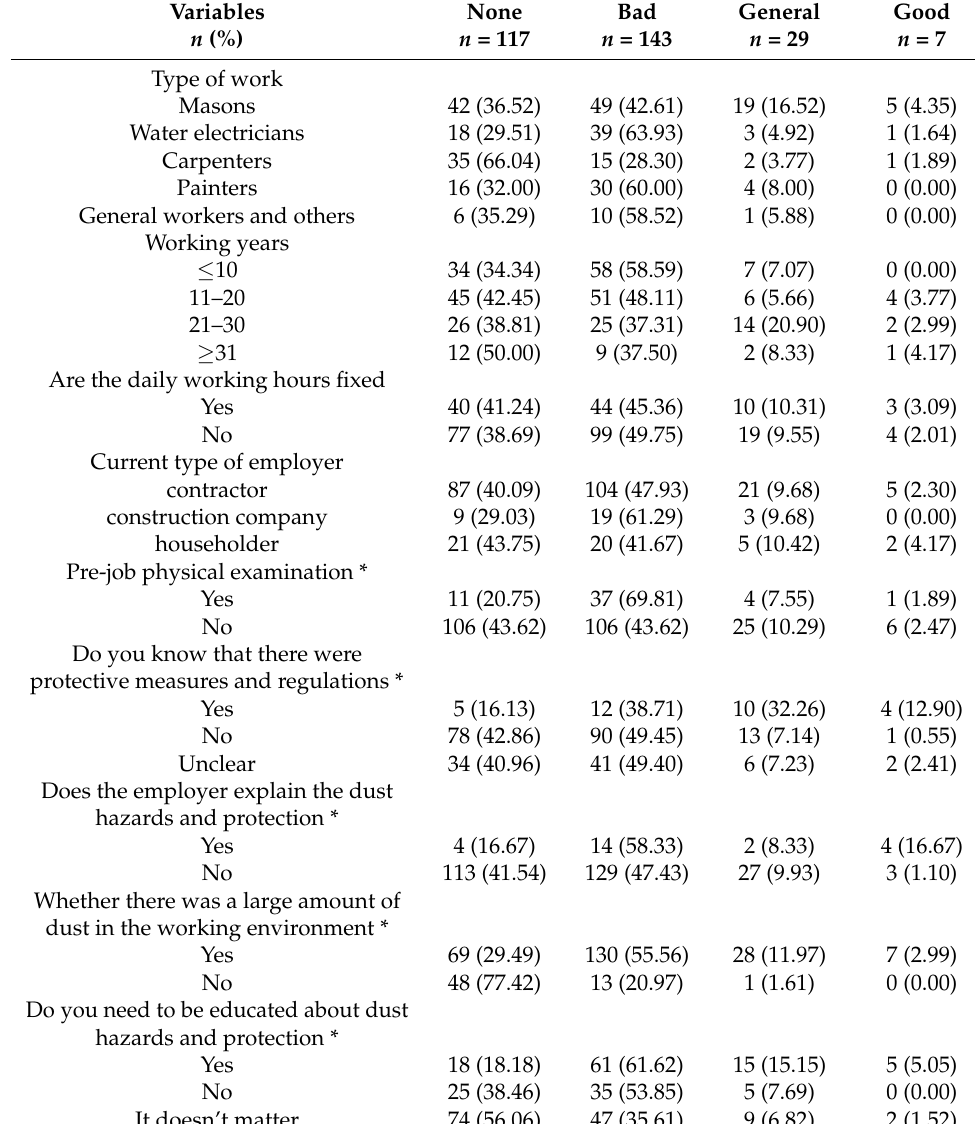
Table 3. Occupational history and protective attitudes of indoor construction workers according to the level of respiratory